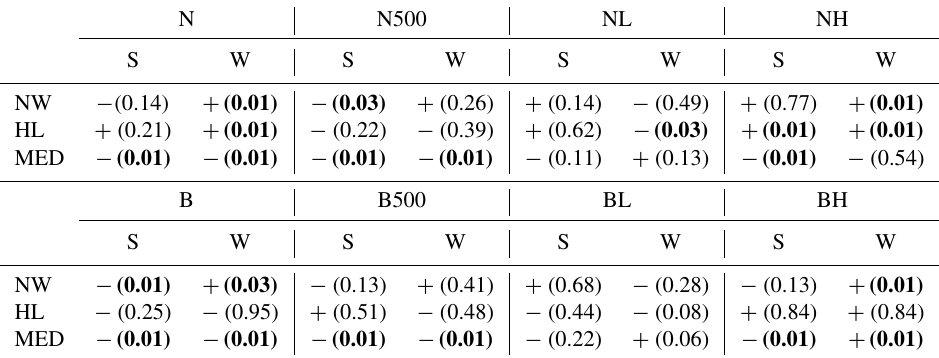
Figure 5. Spatial distribution of the principal component coefficients of Sen’s slope, 1974–2013. Values represented using standard deviation intervals. Sen’s slope classes are based on the following intervals: decrease ( < − 2.5), small decrease ( − 2.5; − 0.5), stable ( − 0.5; 0.5), small increase (0.5; 2.5) and increase ( > 2 . 5). Table 3. Signed p value of Mann–Kendall test in the period 1974–2013 by fire feature, season and region. Values in bold correspond to significant trends ( p value < 0 . 05), with their corresponding symbol + or – for positive or negative trends, respectively. NW is the Northwest; HL is the Hinterland; MED is the Mediterranean region. See Sect. 2.1 for acronyms and description of fire